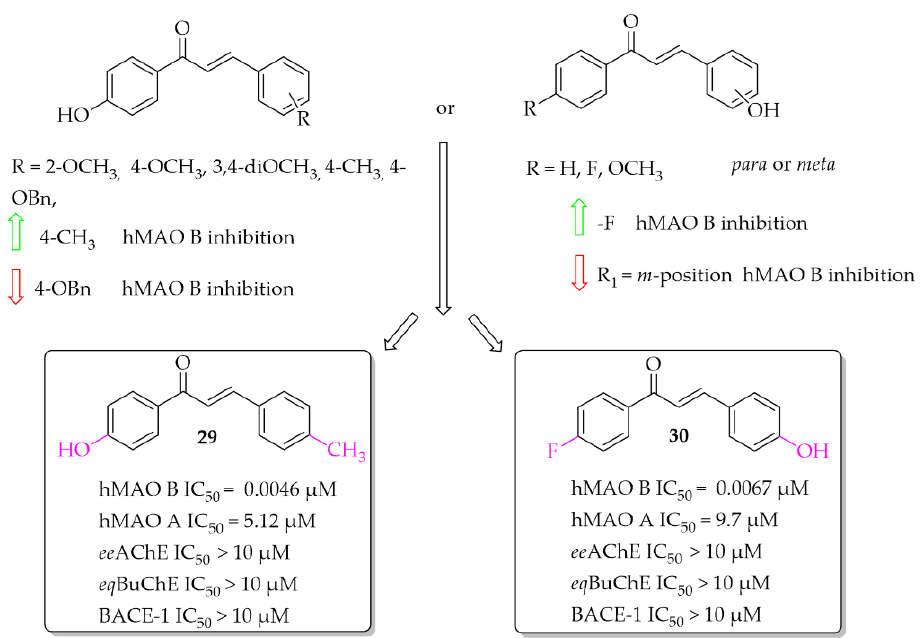
Figure 21. Hydroxychalcones and the most potent compounds in this series [46]. Coumarin-Chalcones